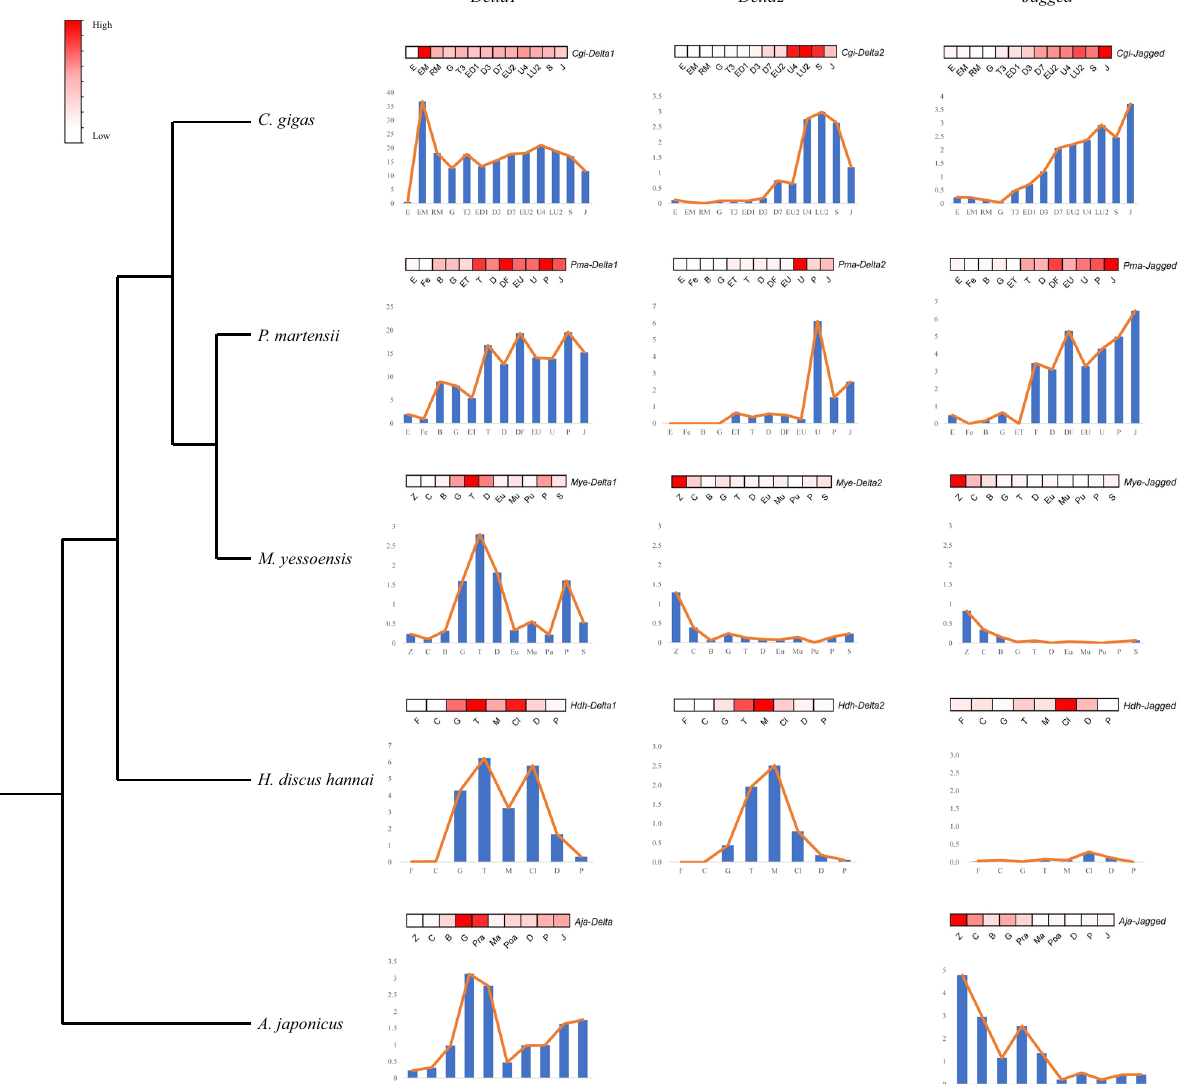
Figure 4. Expression pattern of Notch ligands. Transcriptomic data of five species throughout development ( C. gigas , P. martensii , M. yessoensis , H. discus hannai , and A. japonicus ). Heatmaps in red display the expression trends of genes. The X-axis of histogram shows the developmental points and the Y-axis denotes fragments per kilobase million (FPKM) or reads per kilobase per million (RPKM). Sequence IDs are shown in Supplementary Table S2. Developmental point and species name abbreviations are described in Supplementary Table